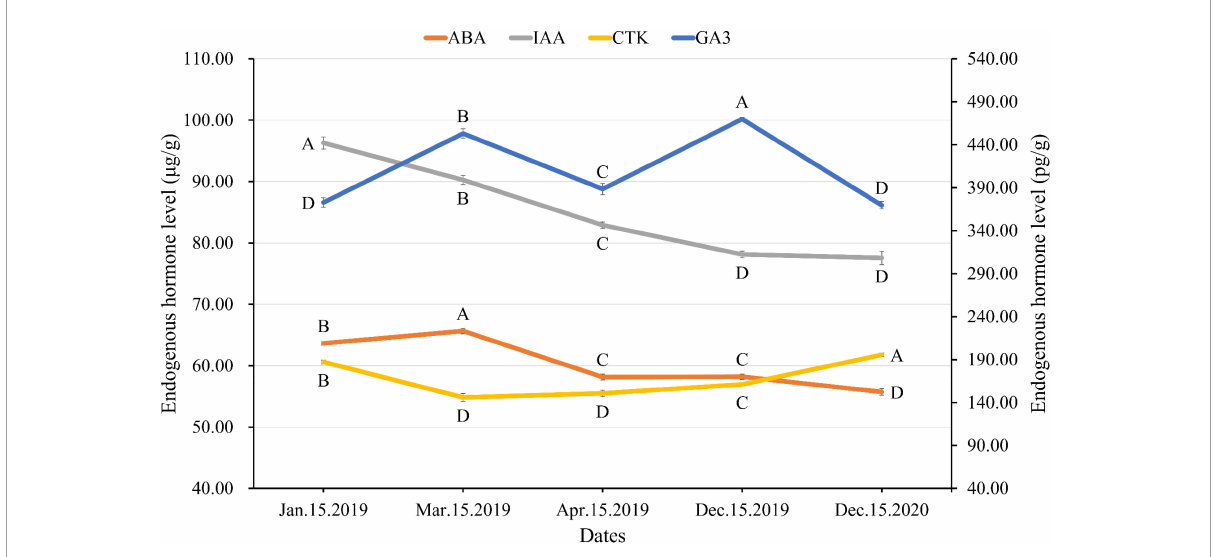
FIGURE4 Endogenous hormone changes in female cones of Dacrydium pectinatum at different developmental stages. Hormones analyzed by ELISA. The unit of GA 3 was pg/g fresh weight (right vertical axis). The unit for abscisic acid, auxin, and cytokinin was µ g/g fresh weight (left vertical axis). Different letters indicate significant difference at p < 0.05, N =